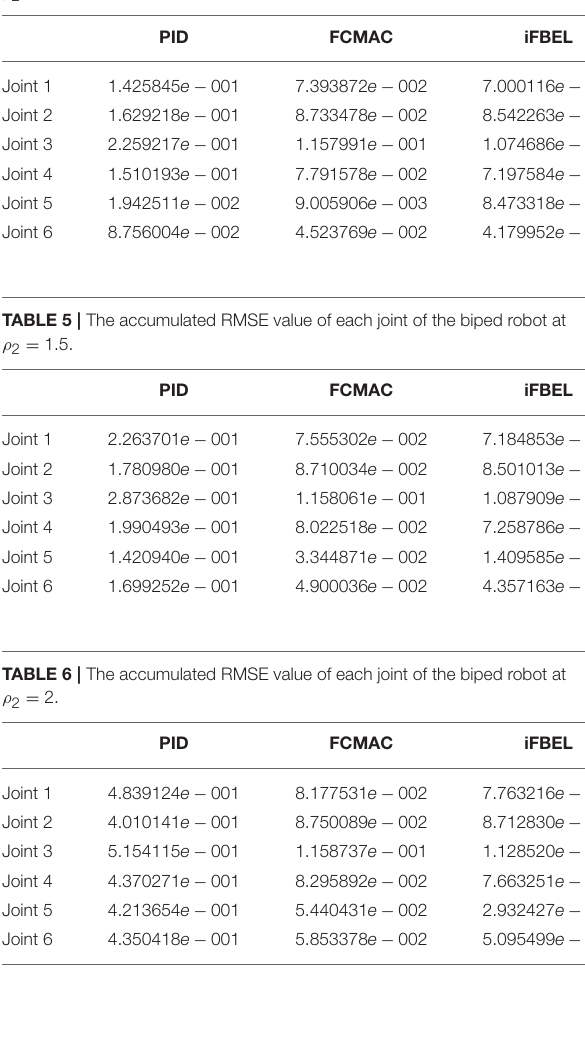
TABLE 4 | The accumulated RMSE value of each joint of the biped robot at ρ 2 = 1.